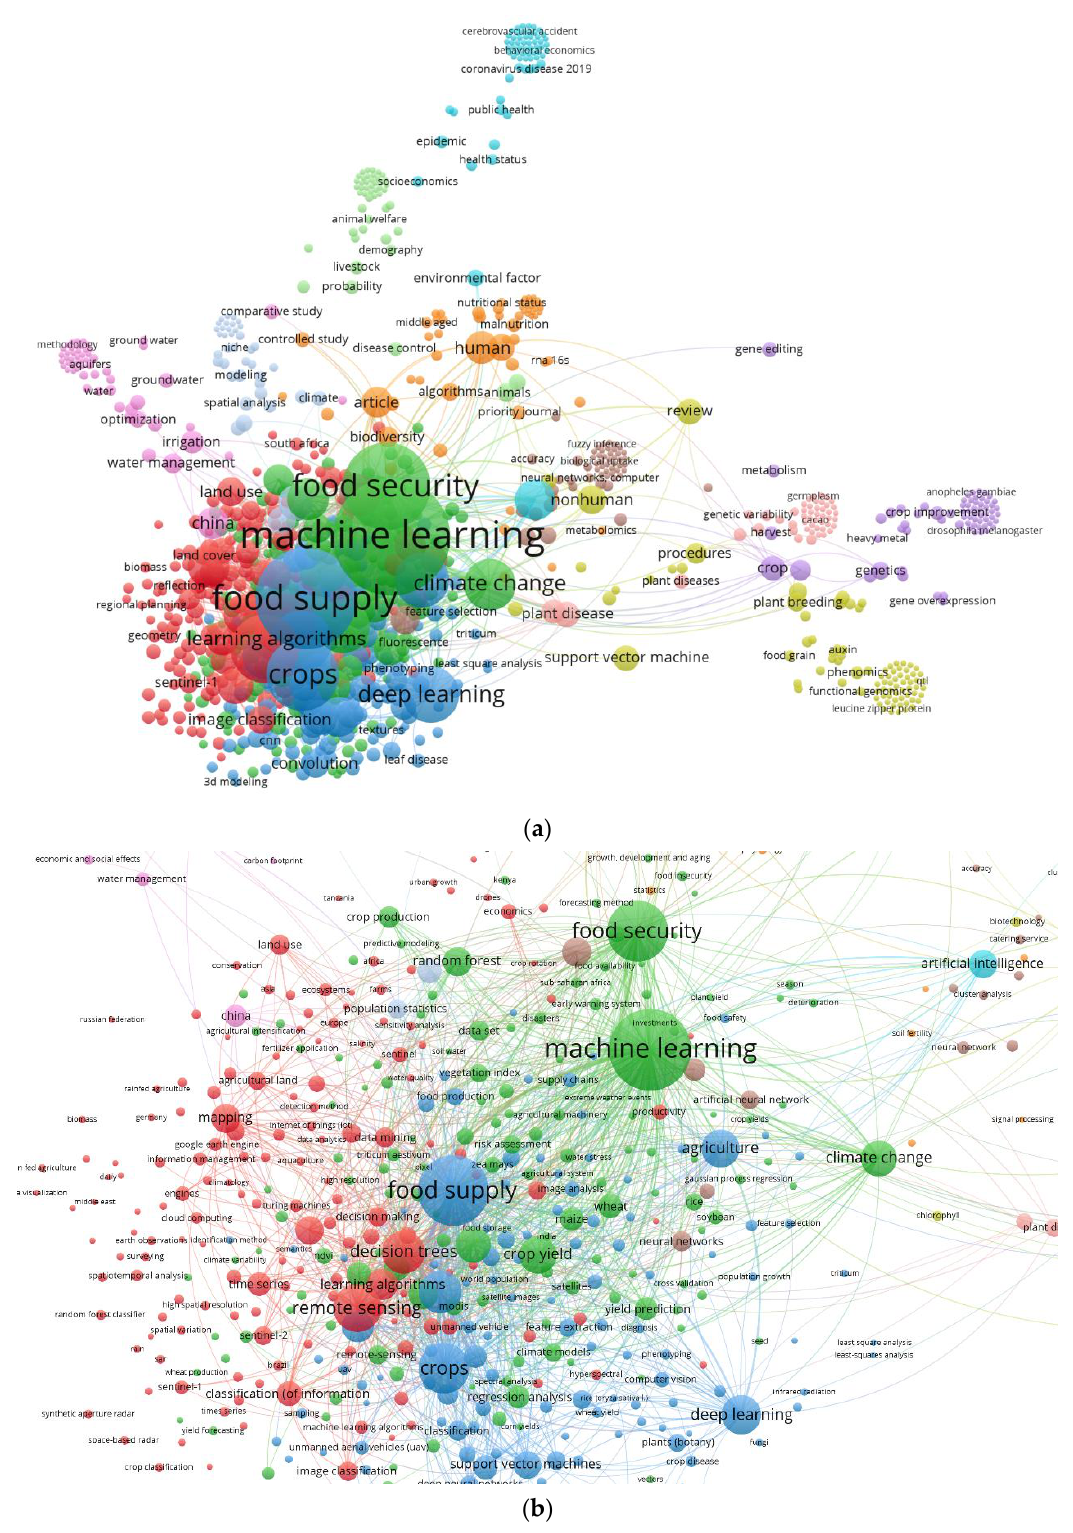
Figure 2. Network visualization map for bibliographic data (co-occurrence links and all keywords as items), considering full counting and 1 as the minimum number of occurrences of a keyword. ( a ) Full network; ( b ) network around the items with the highest occurrences.